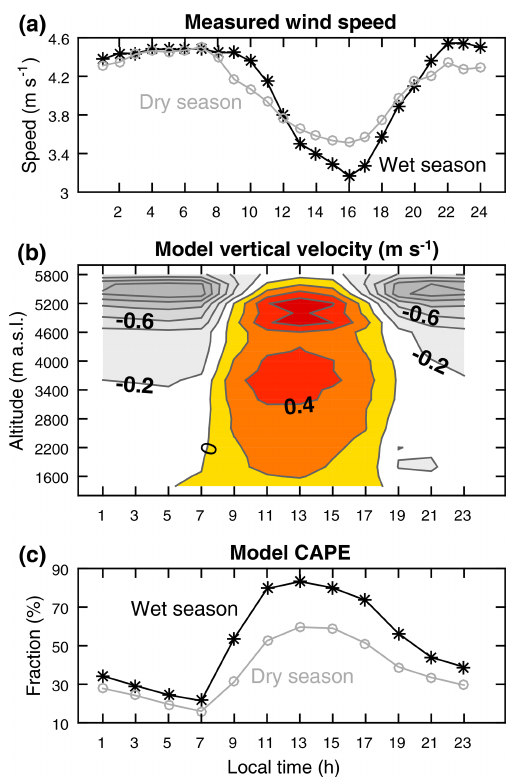
Figure 6. Mean diurnal cycles of (a) measured wind speed at AWS3, (b) vertical velocity on the first model level (16m above ground; contours use 0.2ms − 1 equidistance) over Kibo’s southern slope versus altitude, and (c) modeled areal fraction of convective available potential energy (CAPE) > 0Jkg − 1 on Kibo’s southern slope between 8 October 2009 and 30 September 2013. Panels (a) and (c) distinguish between the climatological dry (JF, JJAS) and wet (MAM, OND) seasons in grey and black, respectively. The x ticks in the model plots indicate the available hours of model out-